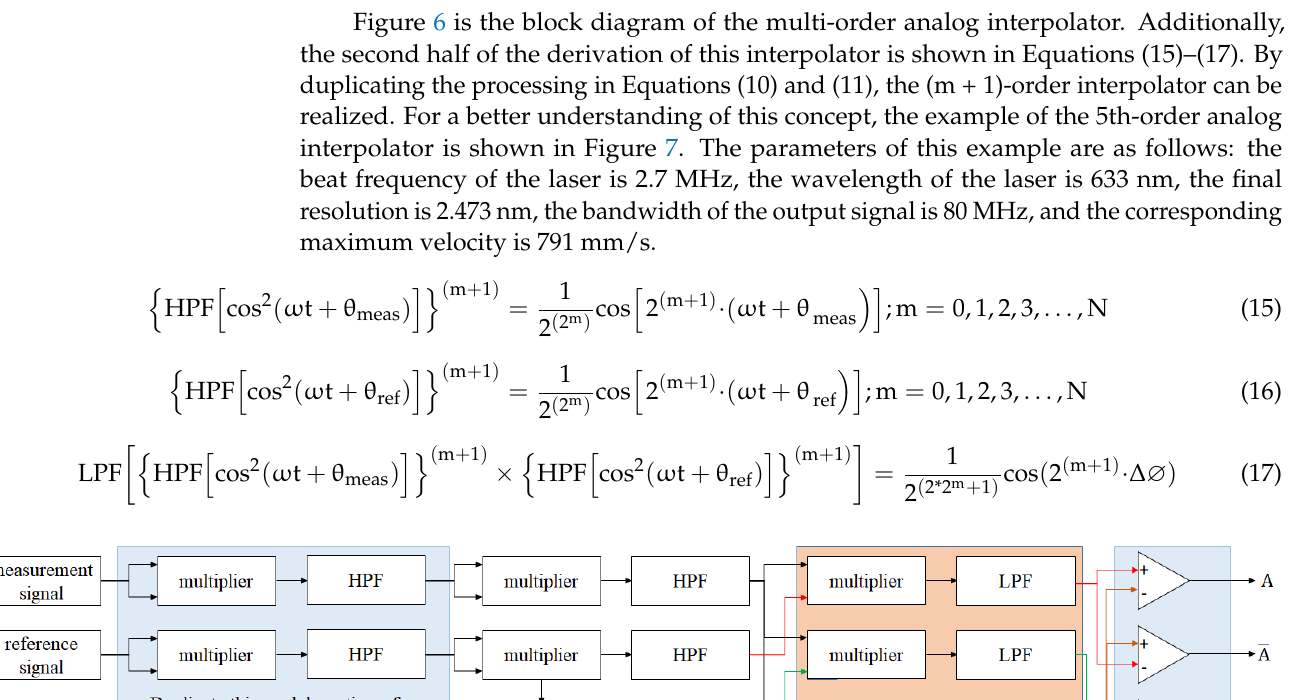
Figure 5. Block diagram of the first-order analog interpolator.